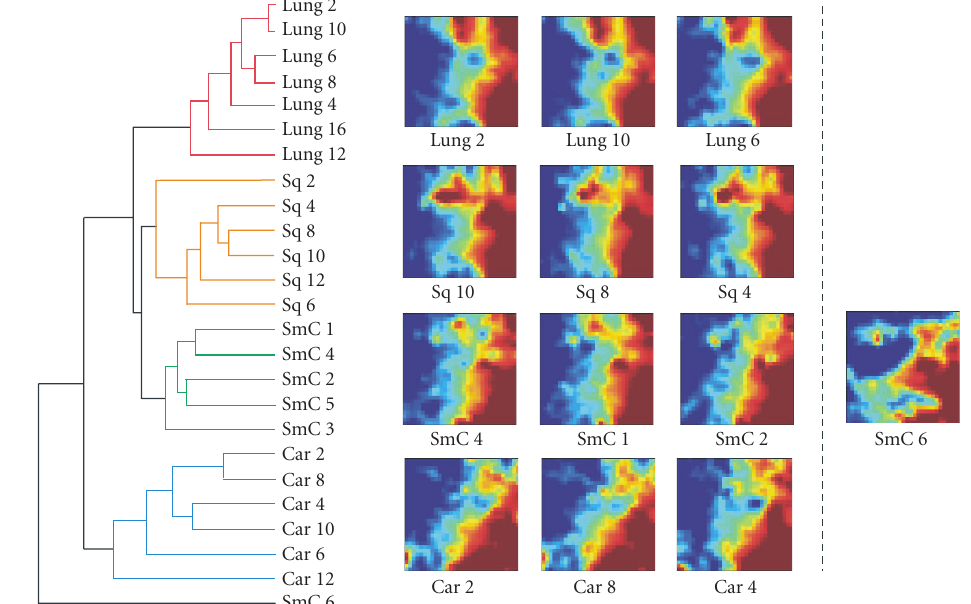
Figure 1: Comparison of GEDI maps and hierarchical clustering. Left: dendrogram from hierarchical clustering, computed from 12562 genes showing 4 main clusters of samples indicated by colors (Lung = normal lung, Sq = squamous cell carcinoma, SmC = small cell lung cancer, Car = carcinoid). Most samples from the same tissue type (diagnosis) form dense clusters. Note that one outlier, SmC6, did not cluster together with the other SmC samples. Right: GEDI maps. Three representative samples of each tissue type (diagnosis) are shown. The outlier sample SmC6 is shown on the right of the other SmC